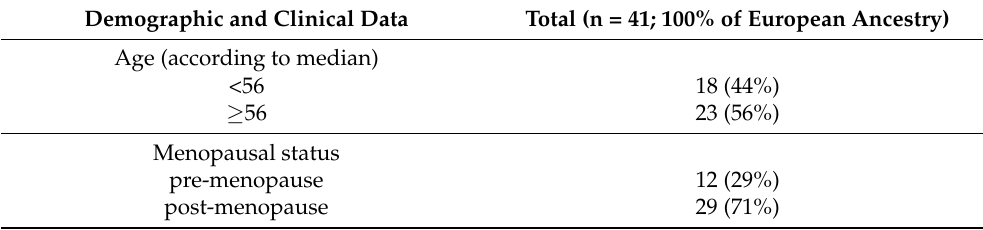
Table 1. Patient